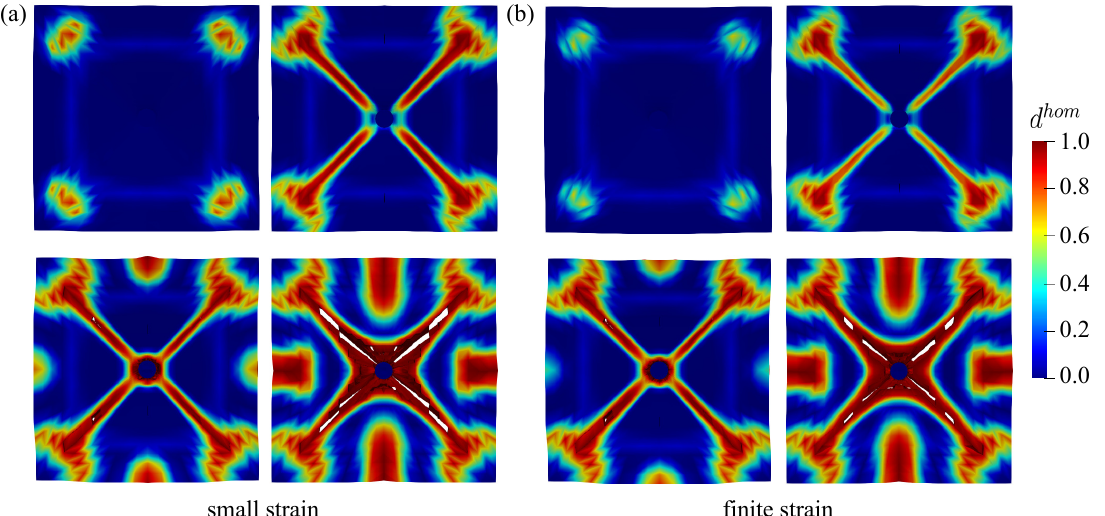
Figure 15. Top view of damage evolution for thick plate impact test: ( a ) small strain and ( b ) finite strain simulation.